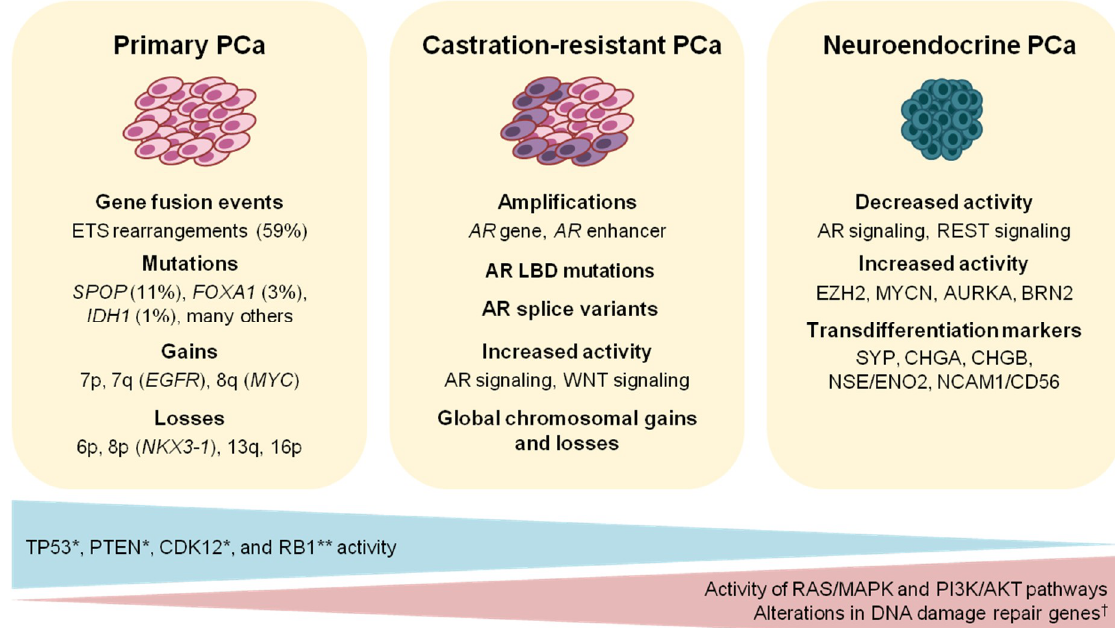
Figure 1. Characteristic molecular alterations in different stages of prostate cancer. Inactivation is markedly observed in castration-resistant (CR) * and neuroendocrine (NE) ** tumors. † Genetic alterations in the DNA damage repair pathways are increased in CR but are almost absent in NE tumors. AR = androgen receptor ; LBD = ligand binding domain .